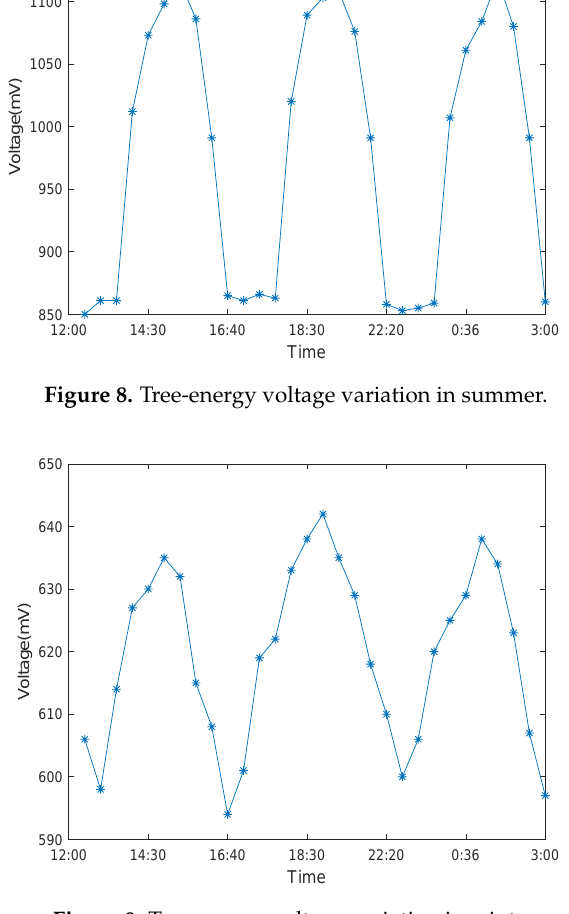
Figure 9. Tree-energy voltage variation in